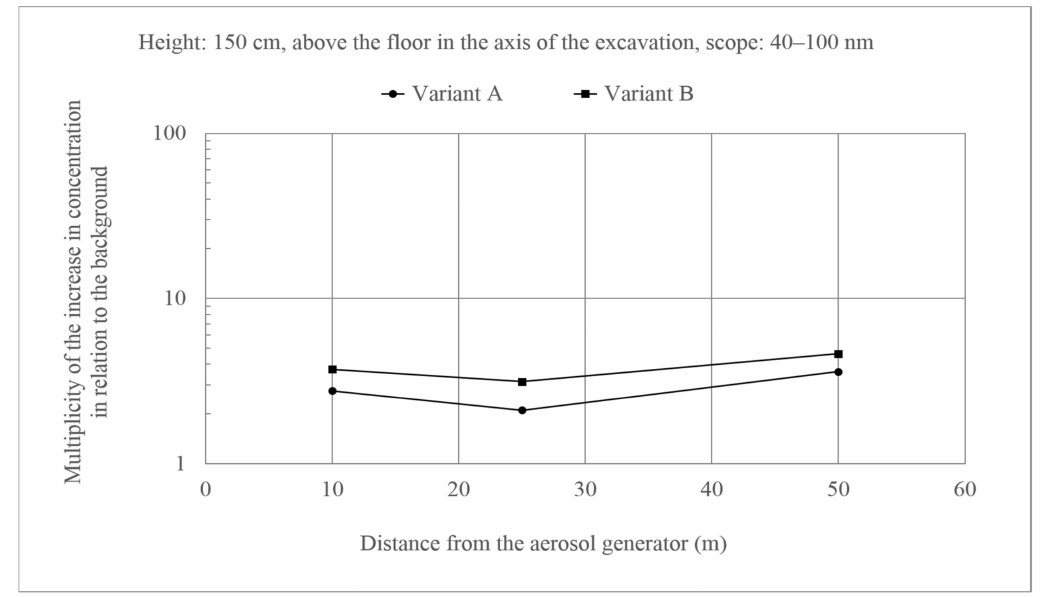
Figure 7. An increase in the concentration of aerosols of the size 40–100 nm at a height of 150 cm above the floor in the axis of the excavation in relation to the background. Generator capacity: 17 cm 3 of